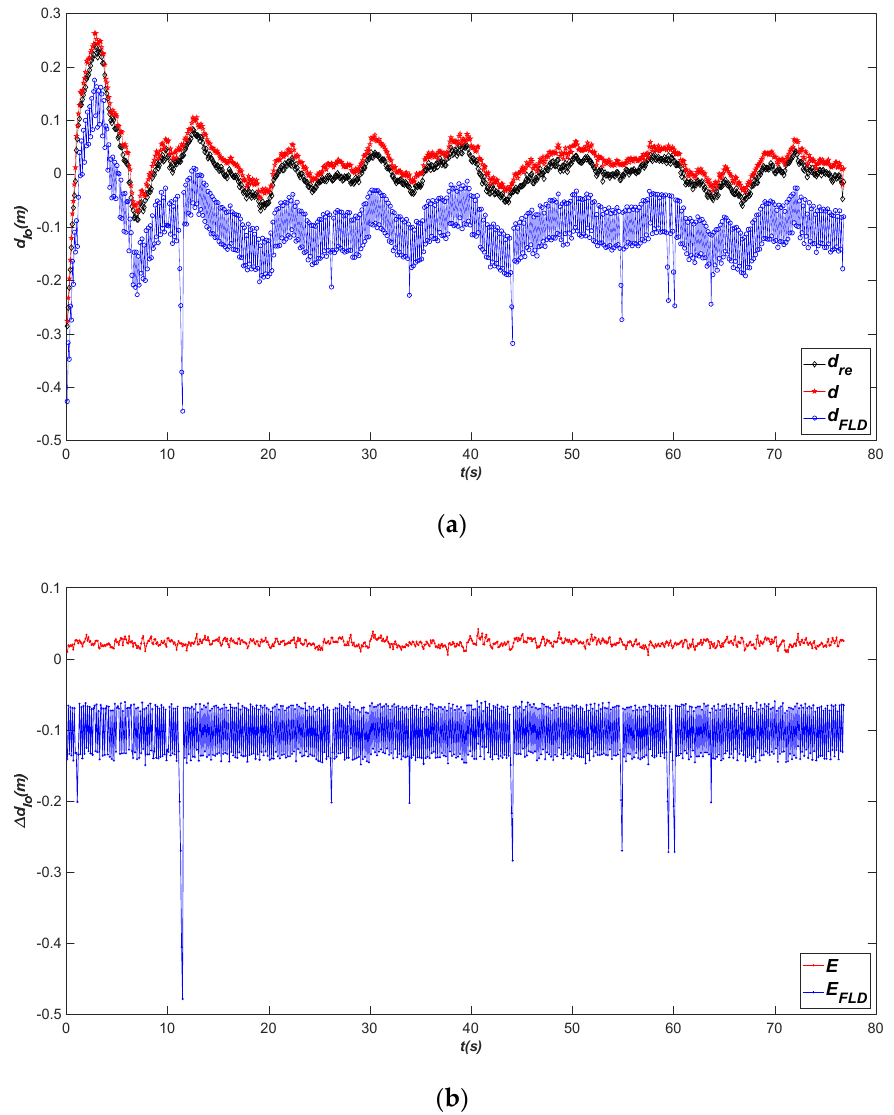
Figure 9. Field harvesting application: ( a ) Schematic diagram of real-time d , d re , and d FLD ; ( b ) schematic diagram of real-time E and E FLD. Table 5. Test results of field harvesting application.